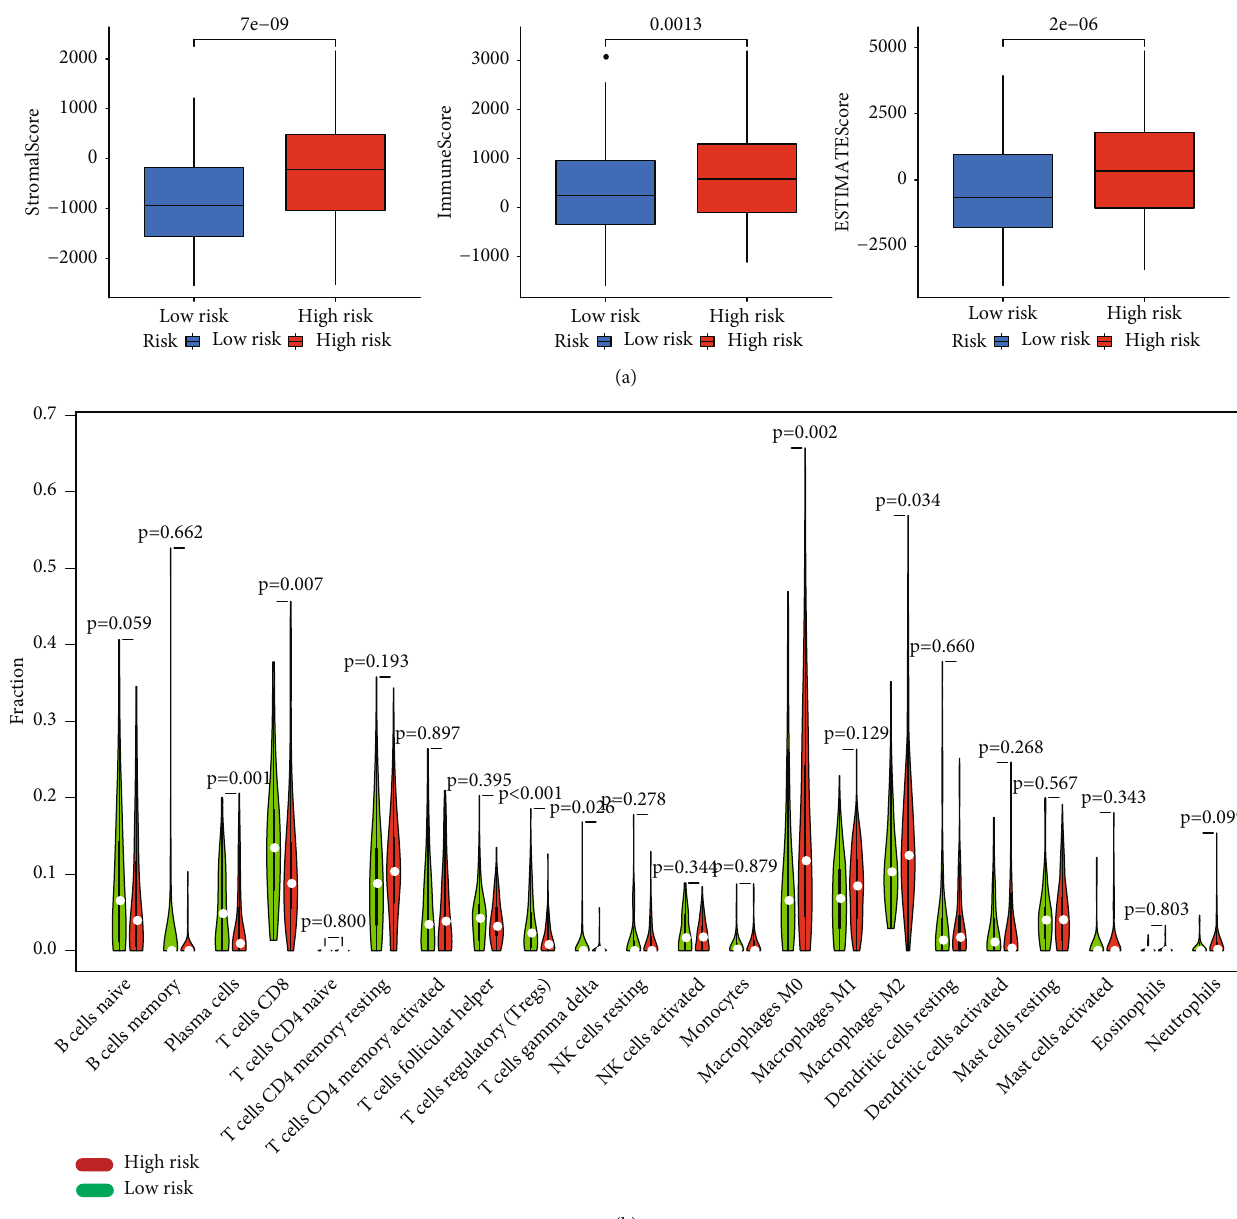
Figure 6: The relationship between PPARscore and tumor microenvironment. (a) Boxplot showed the relative expressions of ESTIMATE score, immune score, and stromal score between high- and low-risk groups by the ESTIMATE algorithm; (b) violin plot compared the expressions of 22 immune cells in fi ltrating between the high- and low-risk groups by the CIBERSORT algorithm. The red signi fi ed the high-risk groups, and the blue signi fi ed the low-risk